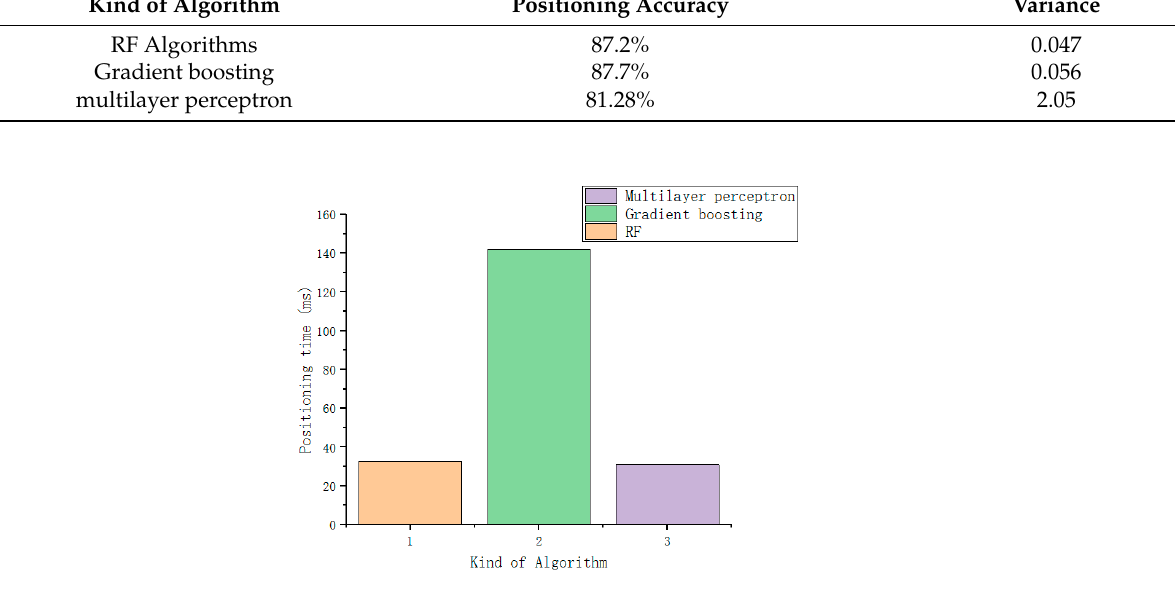
Figure 9. Algorithm positioning time comparison at edge points.